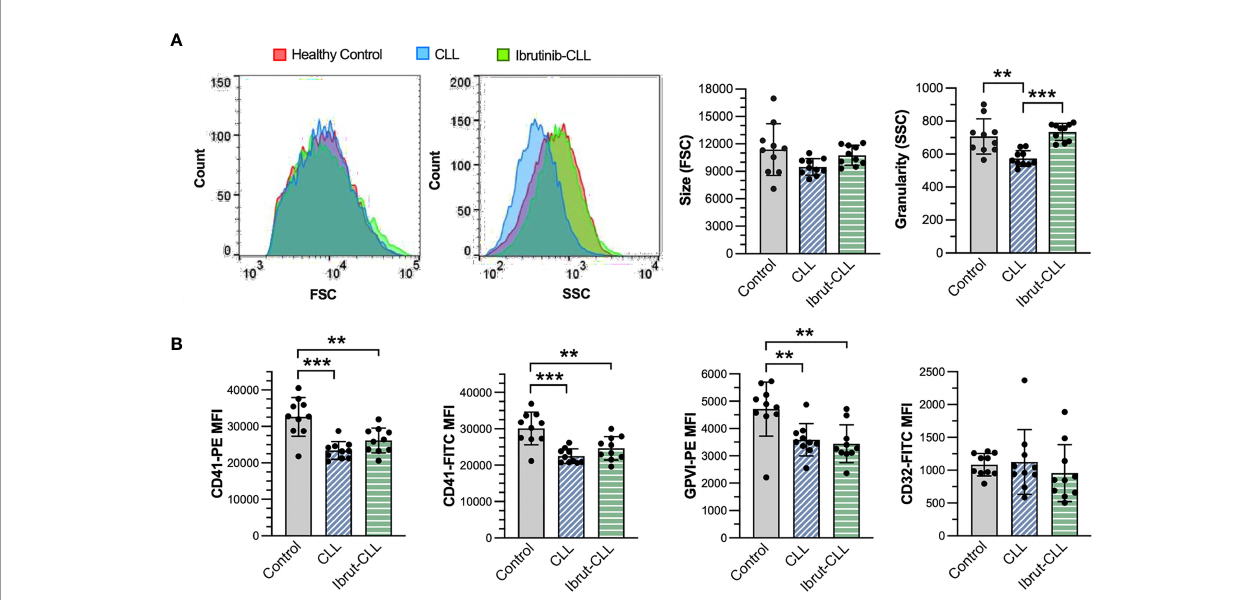
FIGURE 3 | Although different in granularity, platelets from ibrutinib-treated and untreated CLL patients similarly reduce membrane expression of a IIb b 3 and GPVI, but not Fc g RIIA. PRP samples from healthy donors (n=10), CLL (n=10) and ibrutinib-treated CLL (n=10) patients were diluted to 1 x10 7 platelets/ml and incubated with monoclonal antibodies against human integrin a IIb (CD41), GPVI and Fc g RIIA (CD32) before being analyzed by fl ow cytometry. (A) Left histograms show size and granularity in gated platelets, respectively as forward (FSC) and side (SSC) scatter, in representative samples. The bar graphs (right) show the distribution of platelet size and granularity across the three experimental groups. (B) Bar graphs show the mean fl uorescence intensity (MFI) of CD41, GPVI, and CD32 in gated platelets, across the three experimental groups. For CD41, technical replicates with two different antibody clones (PE-conjugated clone 5B12, FITC-conjugated clone P2) are shown (left panels). Statistical signi fi cance was evaluated in ANOVA analyses, followed by Tukey ’ s multiple comparison correction. Data is presented as mean ± SD. (**p ≤ 0.01, ***p ≤